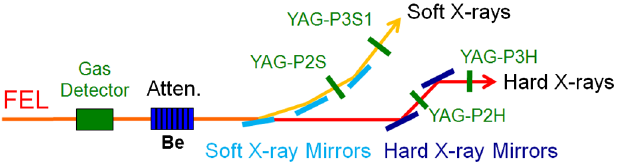
FIG. 2. Schematic of the mirror cutoff measurement. For the soft x-ray line, the ratio of intensities measured on YAG screens P3S1 and P2S gives the transmission for a single mirror, and the total transmission is assumed to be the cube of this ratio.